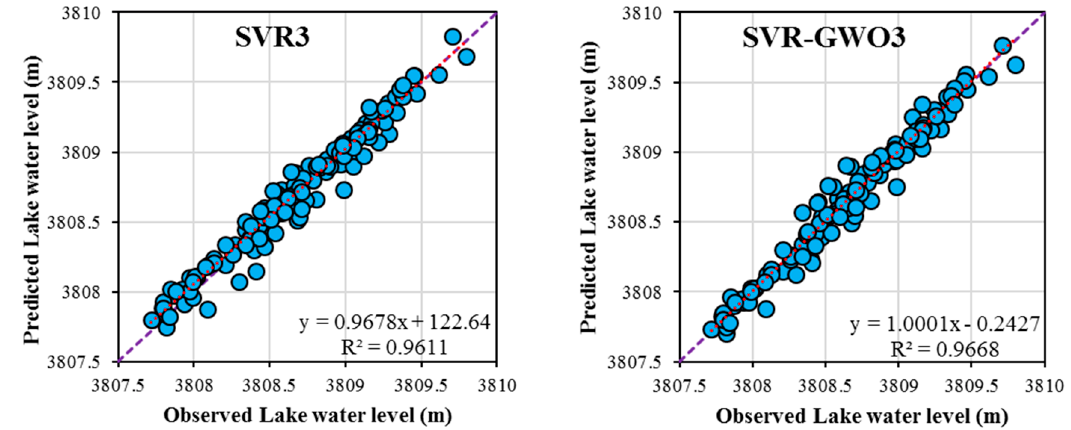
Figure 8. Scatter plot of the predicted lake water level from the SVR and SVR-GWO models versus the corresponding measurements for the testing stage.